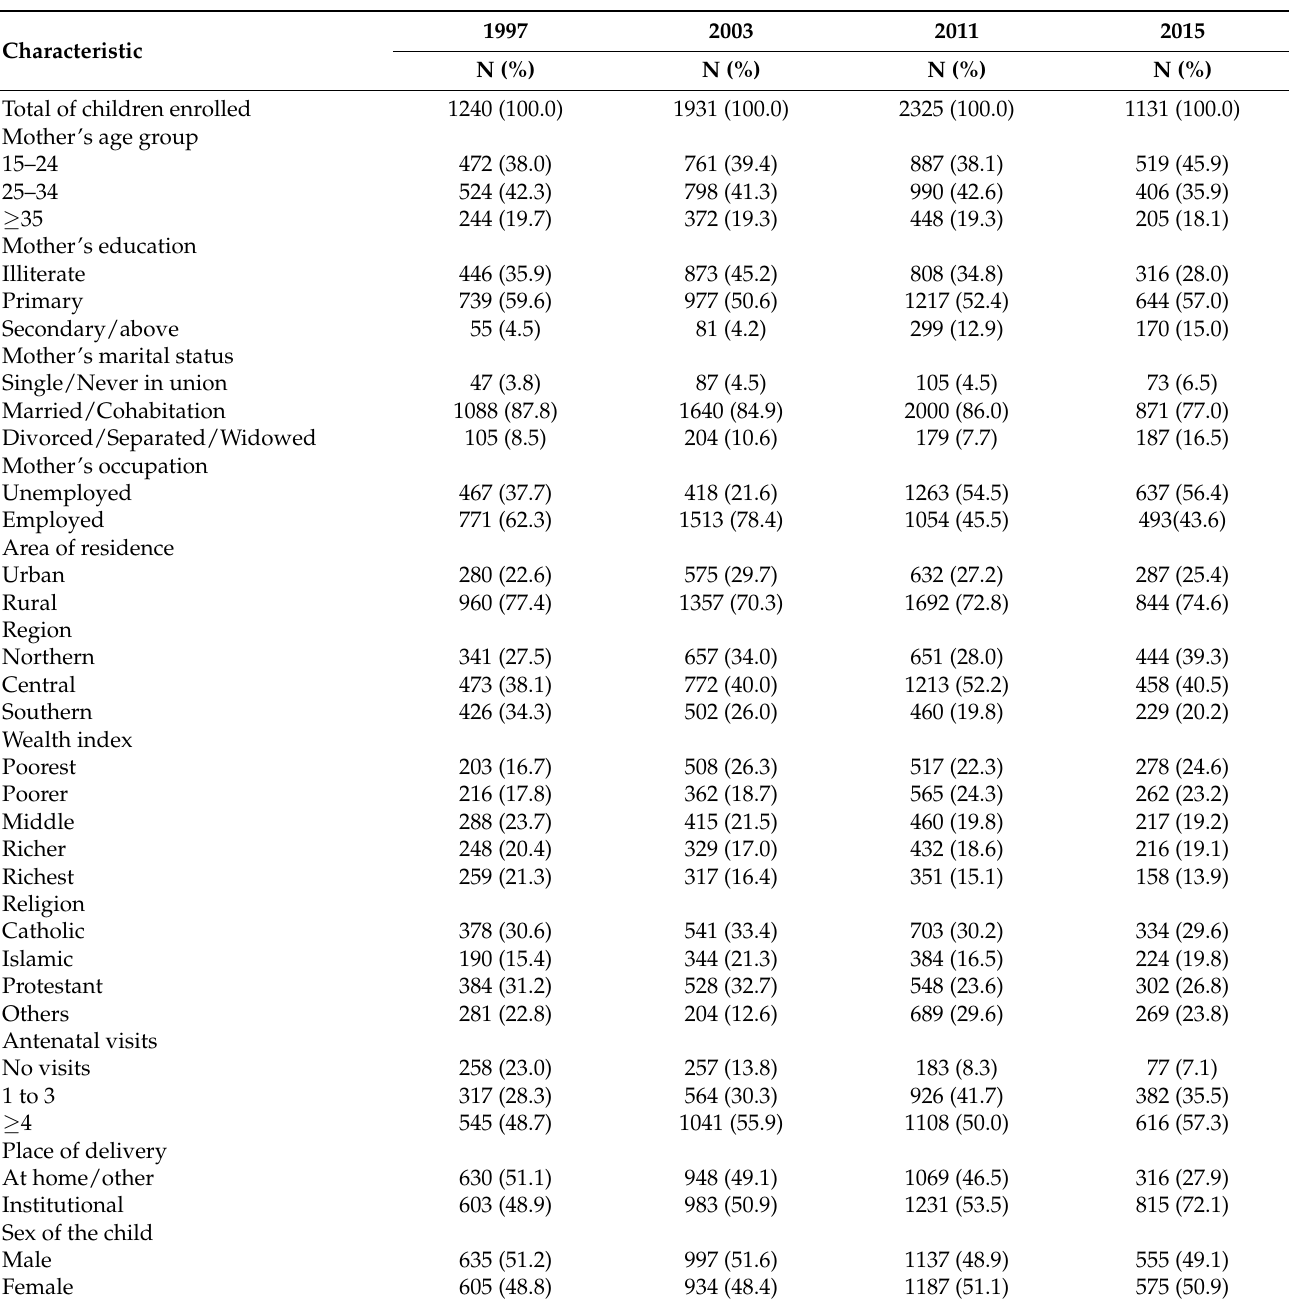
Table 1. Characteristics of the study population from 1997–2015